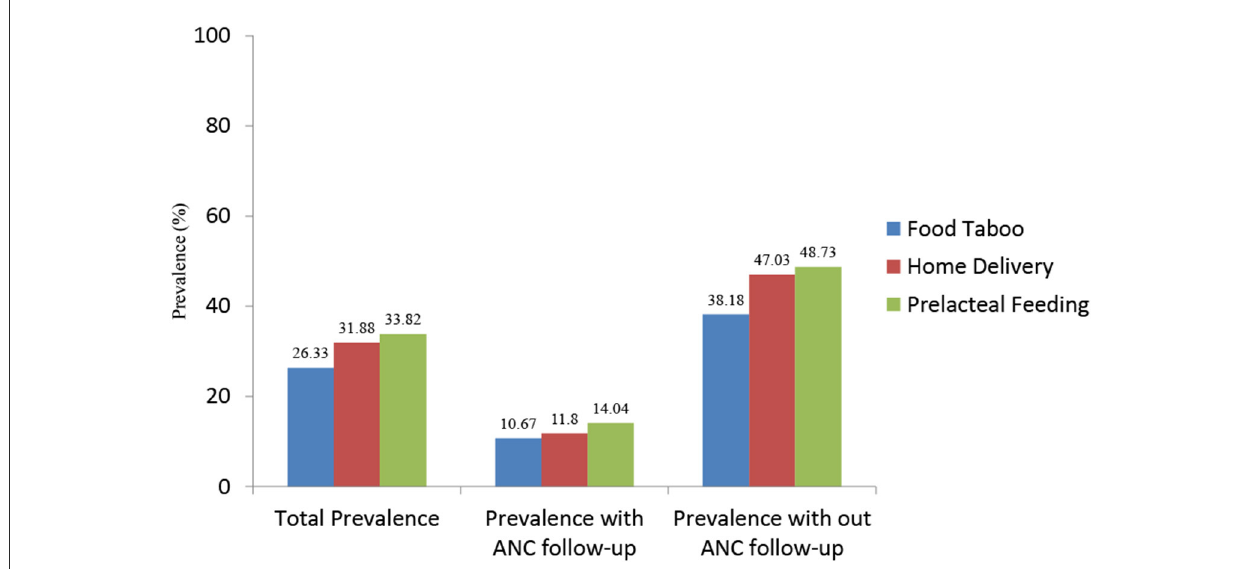
FIGURE2 Prevalence of cultural malpractice during the perinatal period, by ANC follow-up status of women in southwest Ethiopia.